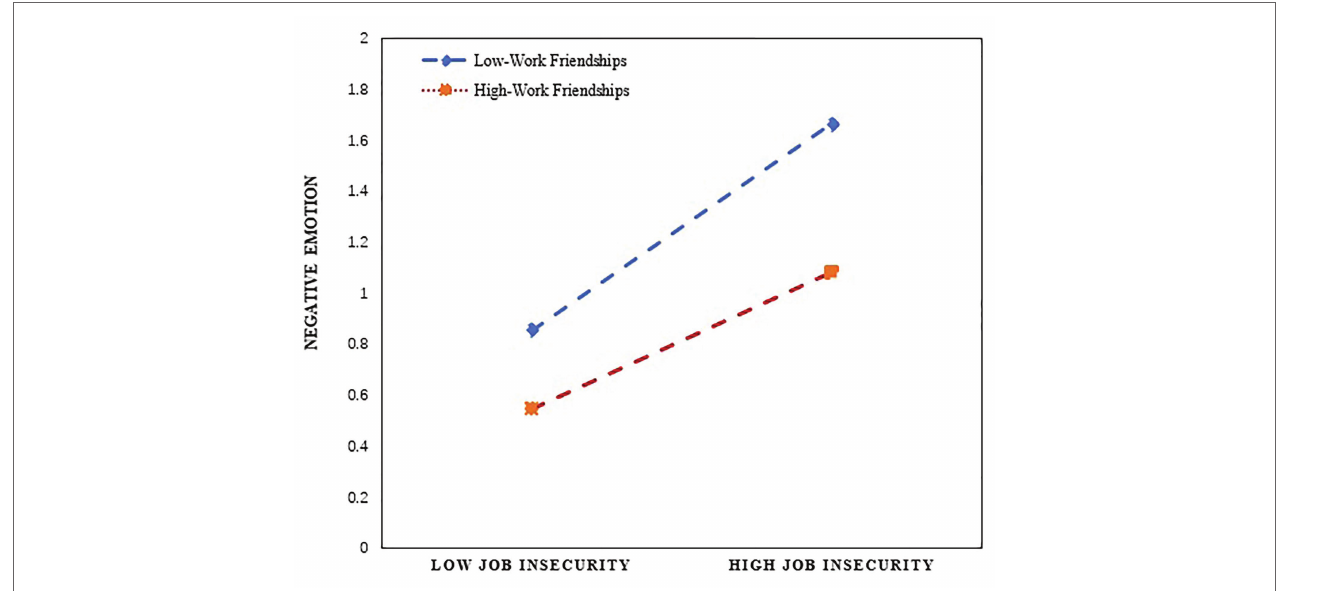
FIGURE 2 | Moderating effect of workplace friendship between job insecurity and negative emotion.